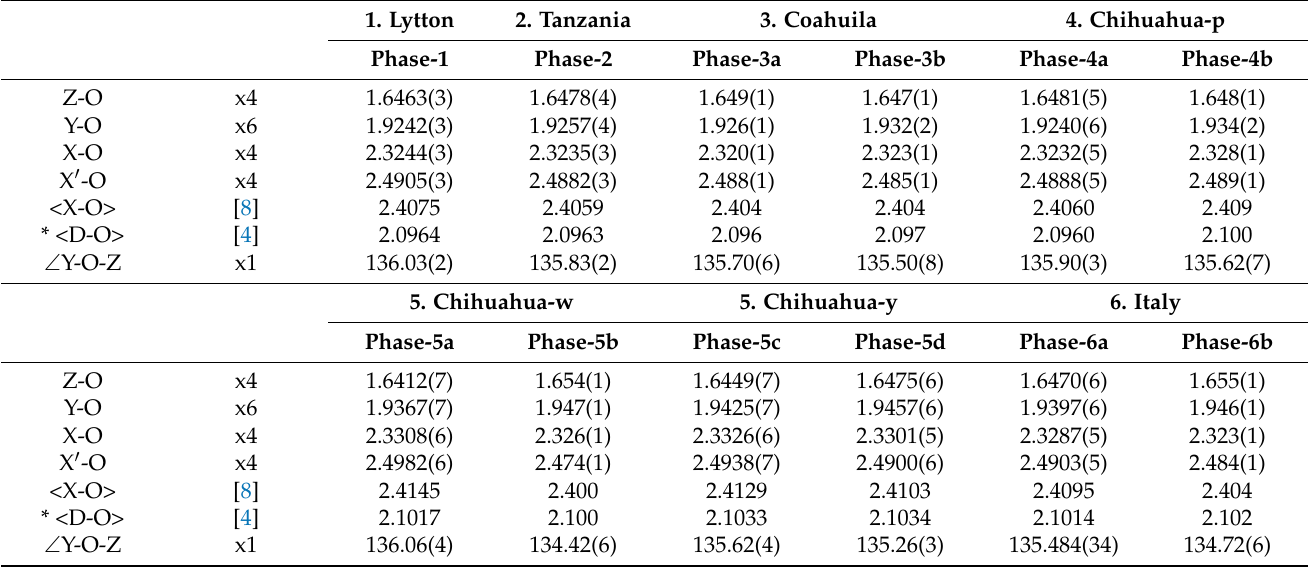
Table 4. Selected bond distances (Å) in six grossular